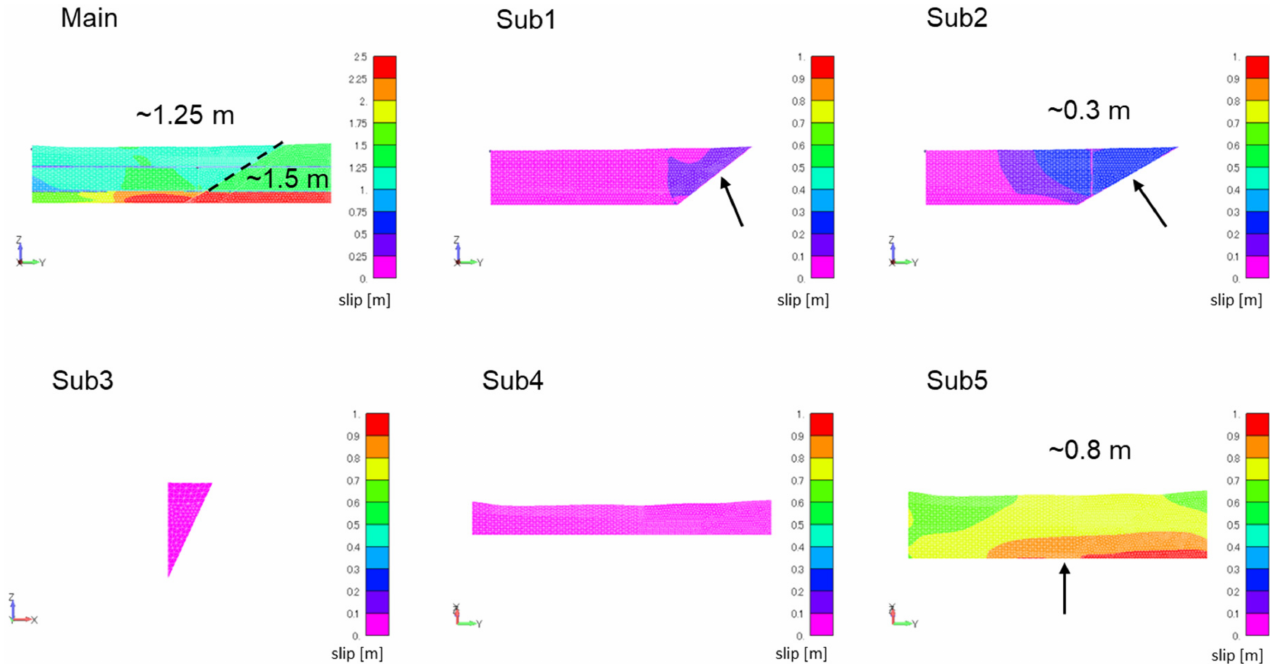
Figure 10. Contours of the slip on the main fault and sub-faults (case1, ∆ = 2.6 m). The dotted line in the figure of the main fault indicates the intersection with Sub2. The black arrows indicate the edges of Sub1, Sub2, and Sub5 where they contact the main fault.